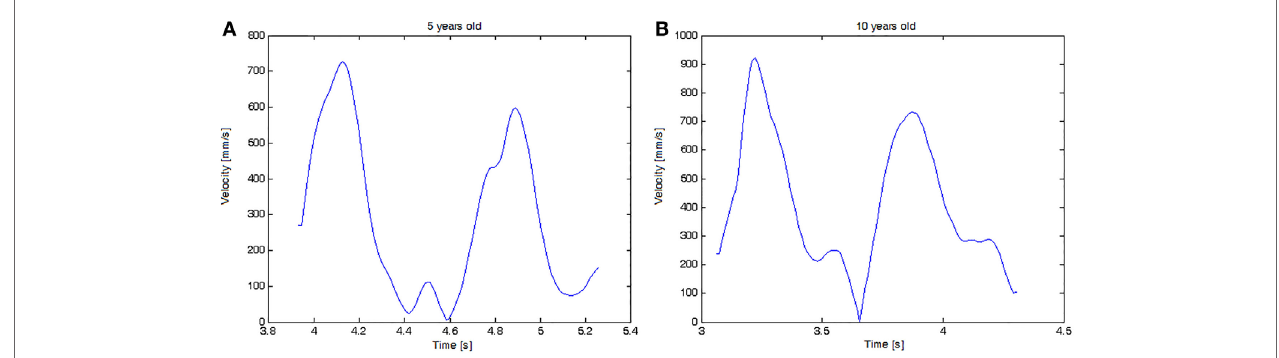
FIgURe 7 | Velocity graph of the complete task cycle for two children: (A) a 5-year-old child with 3 movement units and (B) a 10-year-old child with 2 movement units